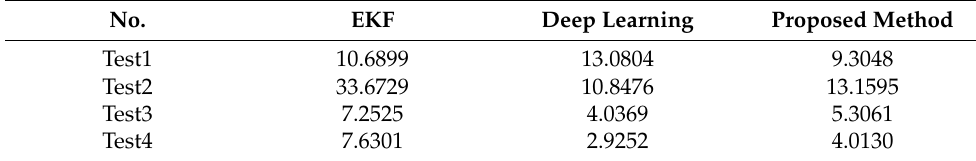
Table 7. Root mean square error (RMSE) of position in different navigation methods. No.